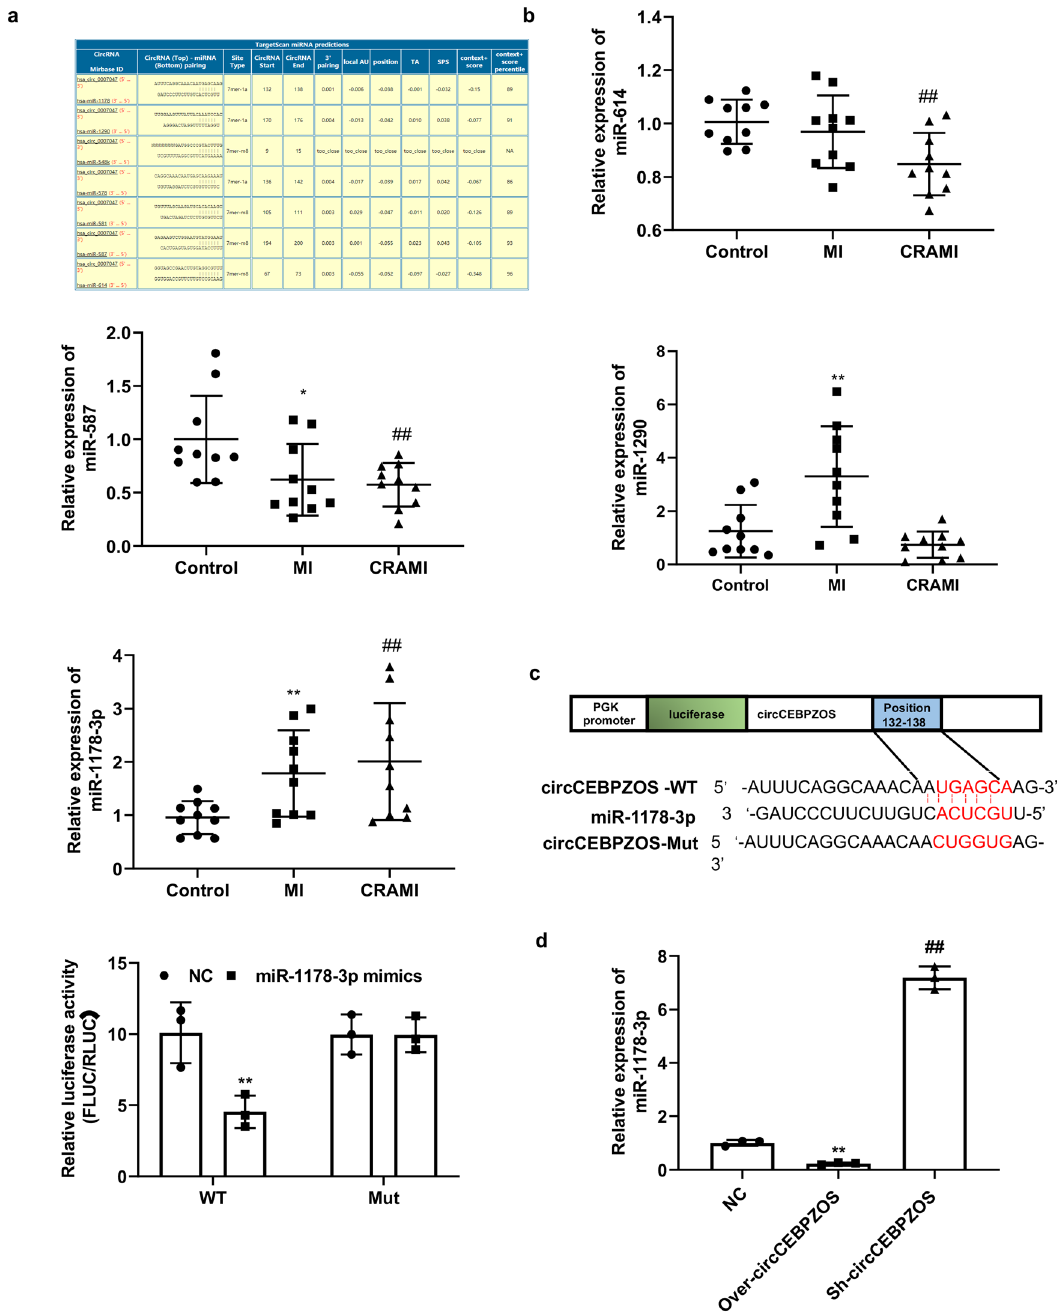
Fig. 4 circCEBPZOS acts as a molecular sponge for miR-1178-3p. a miRNA targets of circCEBPZOS were predicted by CircInteractome. b Expression of miR-614, miR-587, miR-1290 and miR-1178-3p in the EVs of serum from patients with and without postinfarct cardiac remodeling detected using qRT – PCR. Data are mean ± SD. ** P < 0.01, N-CR group vs. Control group; ## P < 0.01, CR group vs. N-CR group. CR, postinfarct cardiac remodeling; N-CR, nonpostinfarct cardiac remodeling. c Dual luciferase reporter system analysis to detect the regulatory effect of miR-1178-3p on circCEBPZOS. d Expression of miR-1178-3p detected in VSMCs coincubated with EVs harboring with Over-circCEBPZOS or Sh-circCEBPZOS, U6 served as control. Data are mean ± SD. ** P < 0.01, Over-circCEBPZOS group vs. NC group; ## P < 0.01, Sh-circCEBPZOS vs. NC